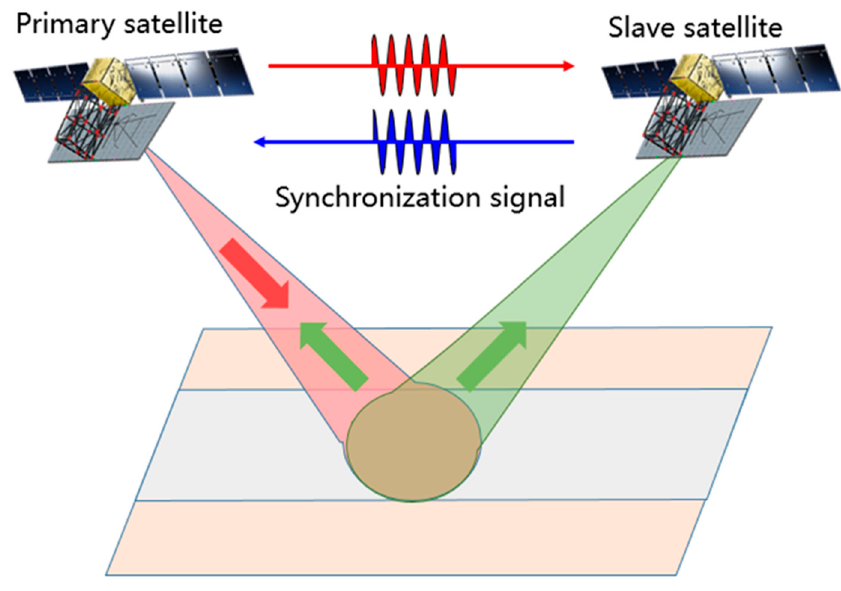
Figure 1. Example of bistatic synthetic aperture radar BiSAR stripmap mode.